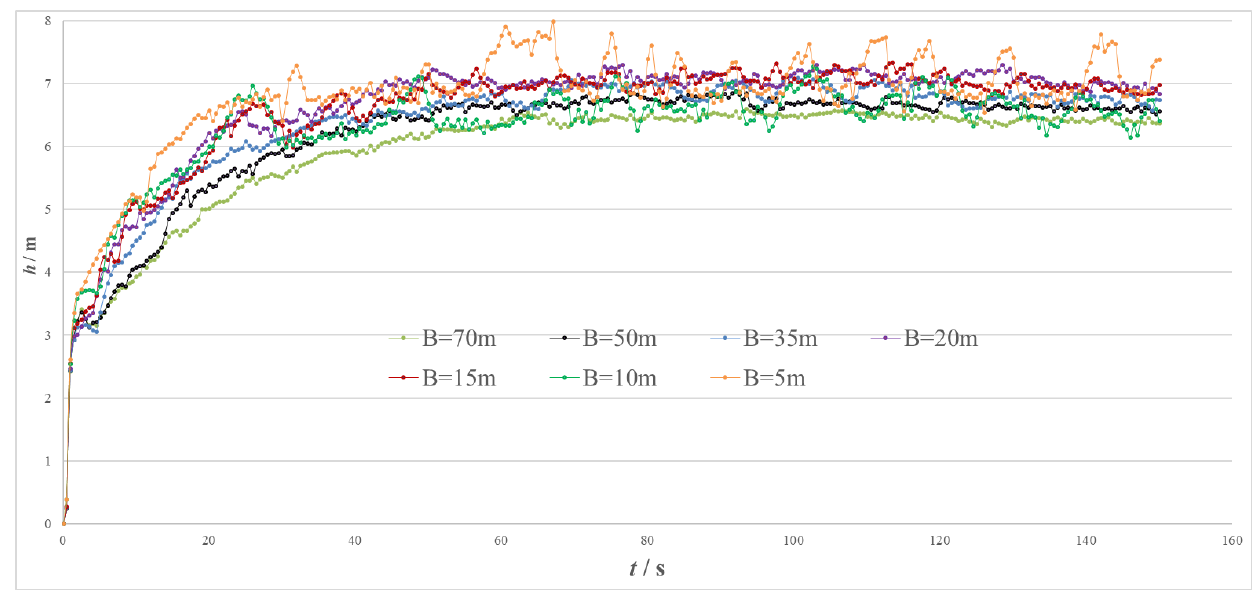
Figure 10. Tracked depth of the mass collapse from a breach of different widths during the dam breaking process.